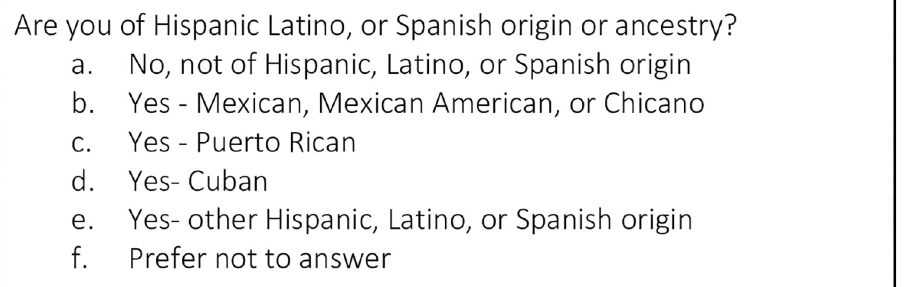
Fig 3. Hispanic ancestry questions in the WISDOM